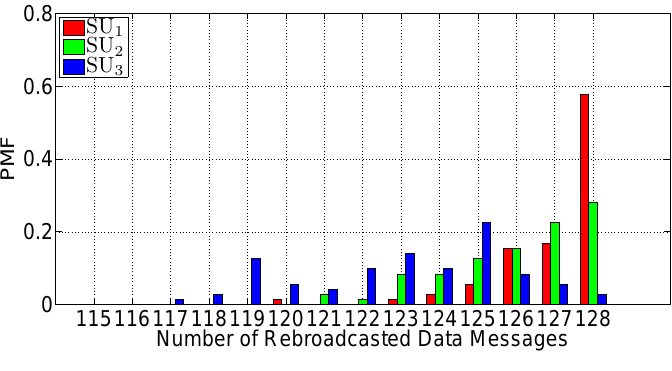
Figure 16. PMF of the number of rebroadcast DATA messages in Scenario